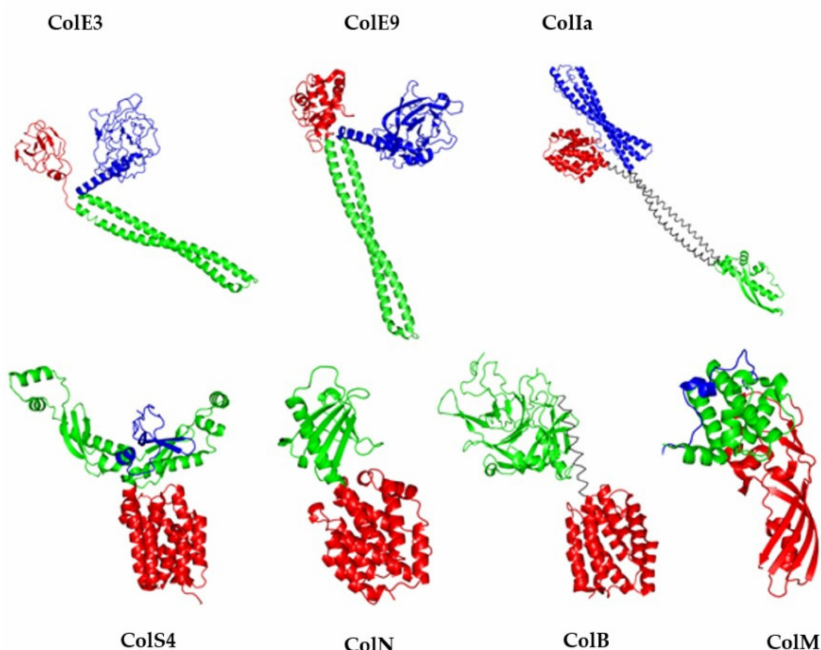
Figure 1. Modular organization of colicins. 3D-structures of ColE3 (PDB entry: 1JCH), ColE9 (PDB entry: 5EW5); ColIa (PDB entry: 1CII); ColS4 (PDB entry: 3FEW); ColN (PDB entry: 1A87); ColB (PDB entry: 1RH1); ColM (PDB entry: 2XMX). For all structures, the translocation domain is colored in blue, the reception domain in green and the activity domain in red. The figure was prepared with the atomic coordinates from the PDB by using PyMOL (DeLano Scientific). 2. Colicin